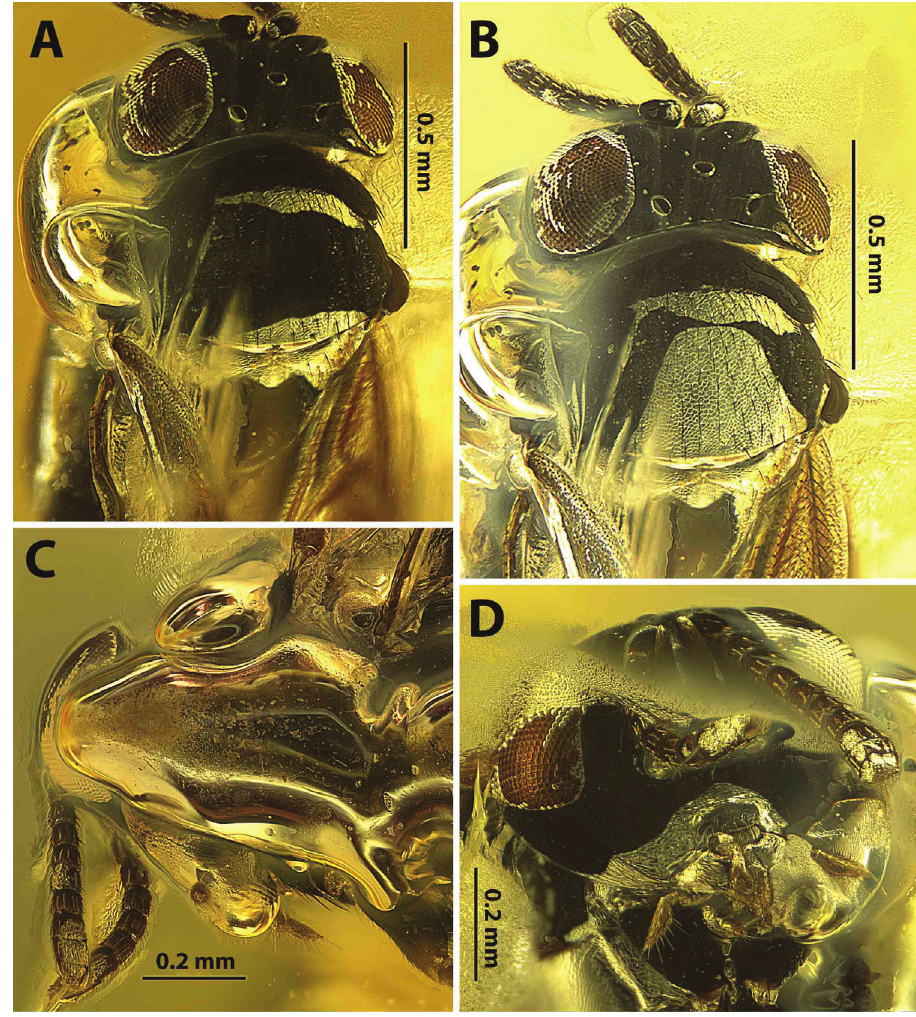
Figure 5. S. glaesaria , female, Rovno specimen A head, mesosoma, dorsal B head, mesosoma with layer of air spread over mesoscutum, dorsal C head, antennae lateral D head, clypeus, mandibles,